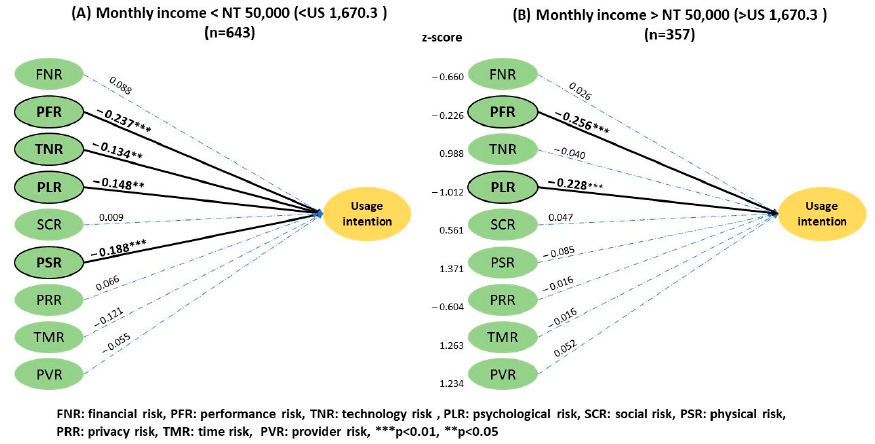
Figure 6. Results of the two-group structural model of educational status.